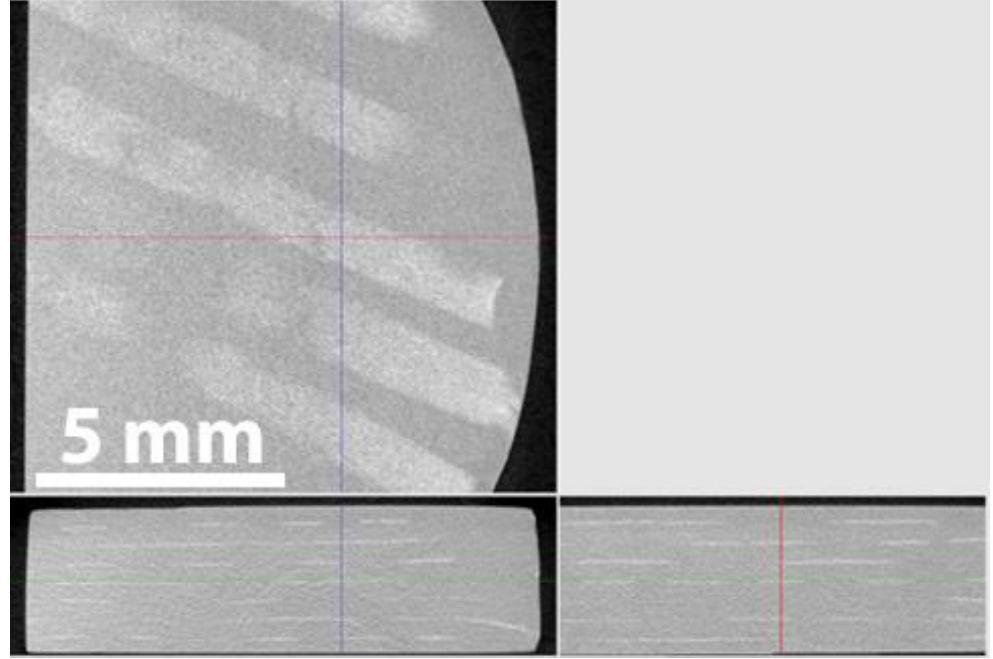
Figure 5. Computed tomography (CT) slices of the SiC f / SiC p composites: parallel ( top ) and transverse ( bottom ).